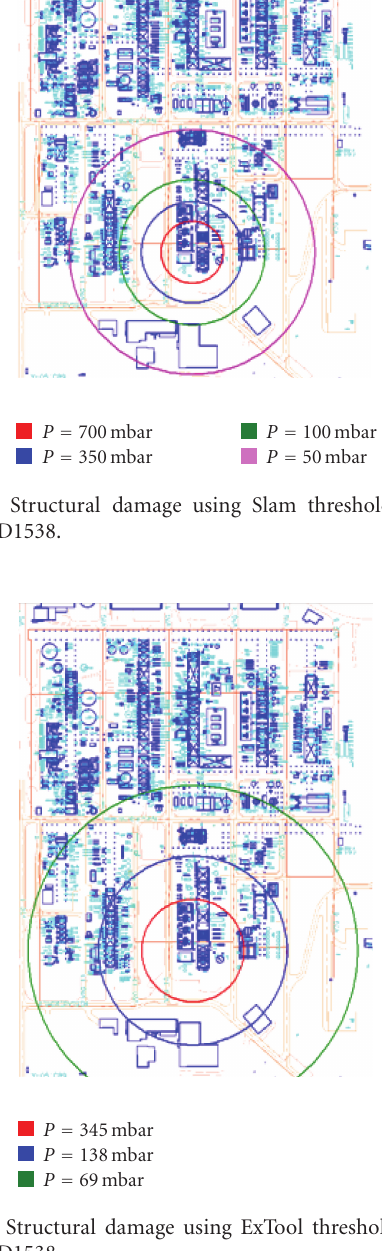
Figure 11: Structural damage using ExTool threshold values for scenario 1: